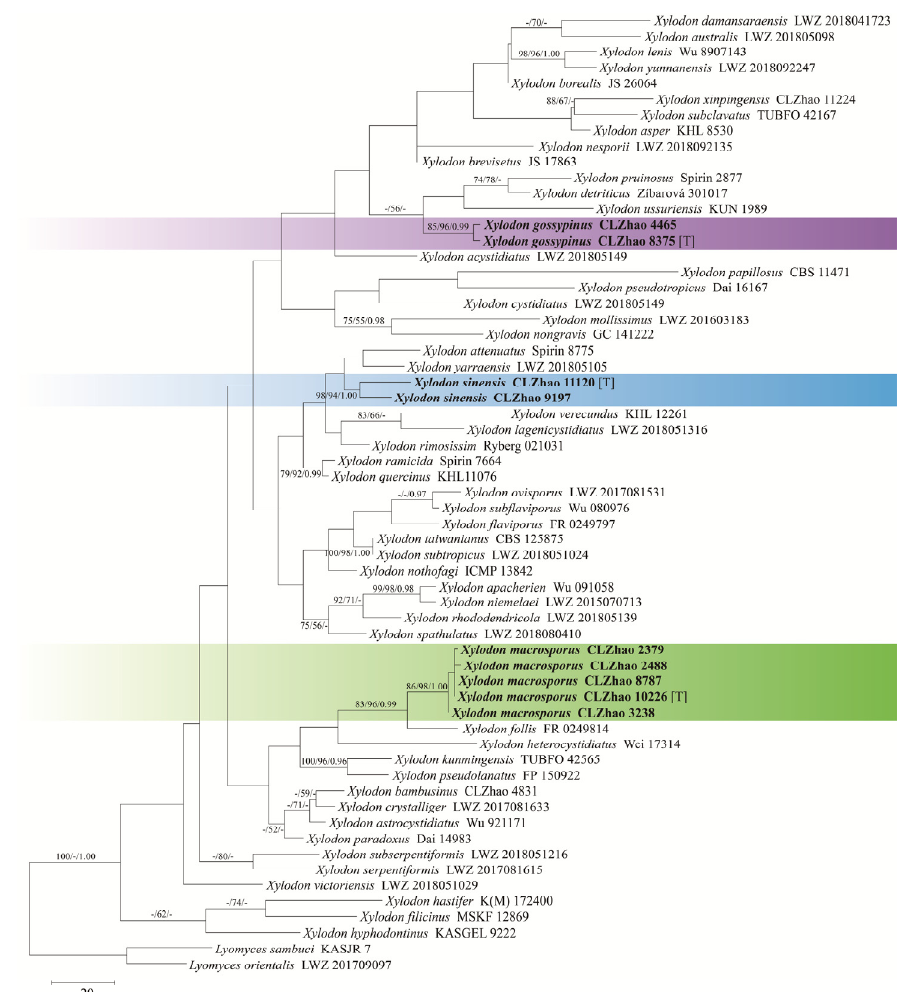
Figure 2. Maximum parsimony strict consensus tree illustrating the phylogeny of three new species and related species in Xylodon based on ITS sequences. Branches are labelled with maximum likelihood bootstrap value >70%, parsimony bootstrap value >50%, and Bayesian posterior probabilities >0.95, respectively. The new species are in bold; [T] is shown type material, holotype.